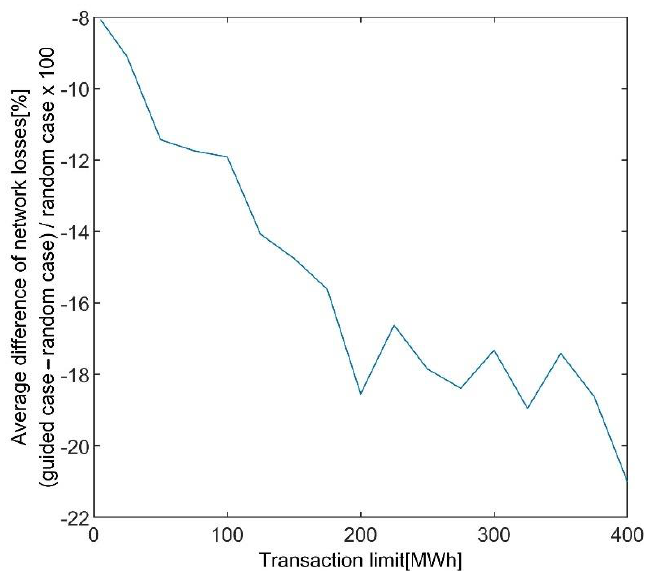
Figure 8. Average difference ratio of network losses between the random case and the guided case in the IEEE 33 bus